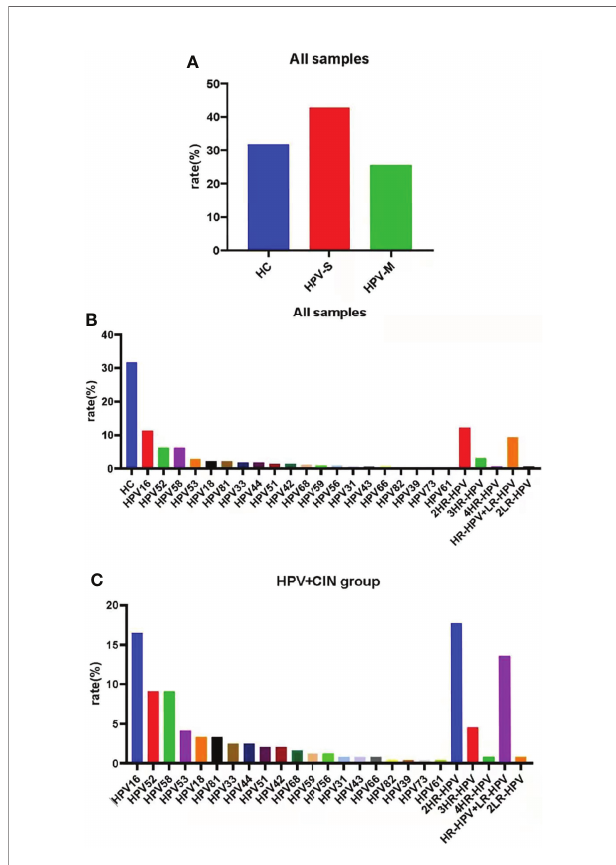
FIGURE 1 | Samples were classi fi ed by HPV subtypes. (A) The percentage of HC group, simple-infection group, and multiple-infection group in all samples. (B) The percentage of special HPV types in all samples. (C) HPV prevalence in the HPV-infected and CIN-diagnosed groups. The top HPVs are HPV16, 52, 58; 2HR-HPV; and HR-HPV +